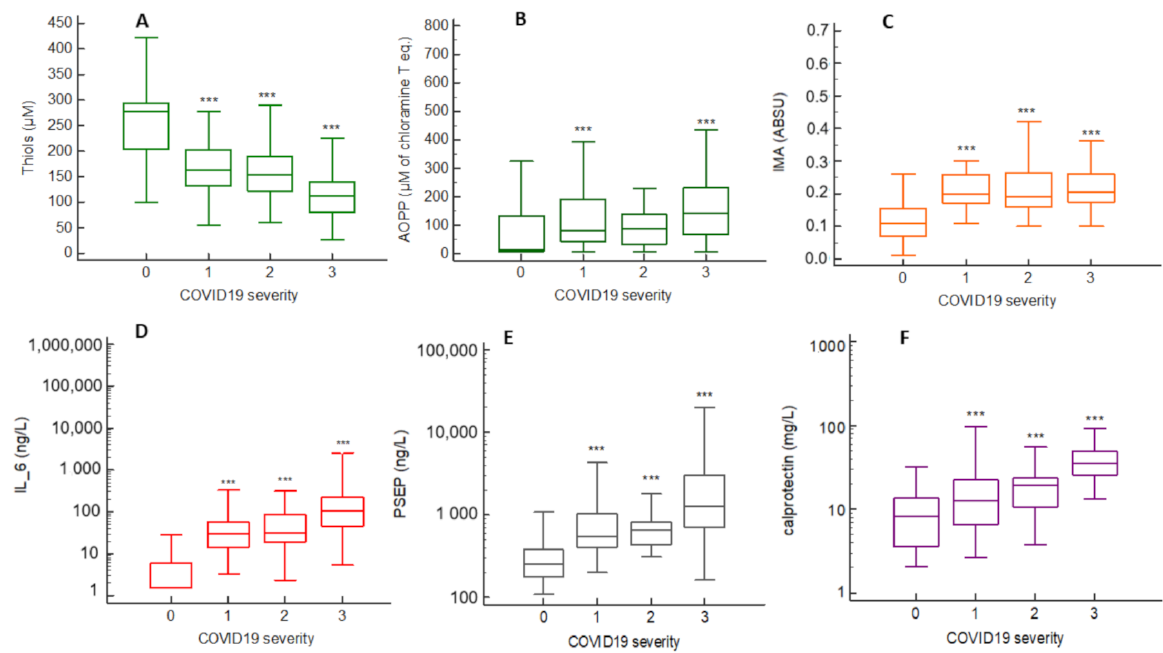
Figure 1. Oxidative stress (OS), inflammation and cell-activation biomarker concentrations across COVID-19 severity stages. ( A ) thiols concentrations; ( B ) AOPP concentrations; ( C ) IMA concentrations; ( D ) IL-6 concentrations; ( E ) presepsin concentrations; ( F ) calprotectin concentrations. ***: p < 0.05 vs. severity